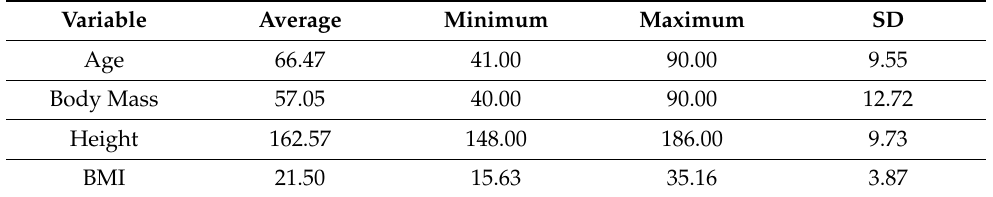
Table 1. Descriptive statistics of age and morphological parameters of patients. BMI = Body Mass Index